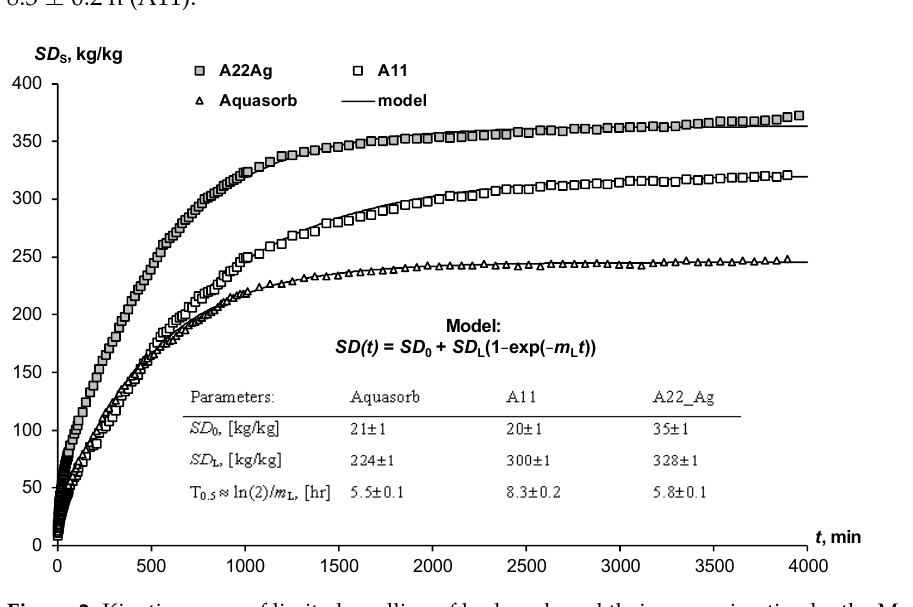
Figure 2. Kinetic curves of limited swelling of hydrogels and their approximation by the Model (27). where SD 0 and SD L are the initial and final (limiting) degree of swelling of the hydrogel, m L , [h − 1 ] is the kinetic constant, approximately (if SD 0 << SD L ) related to the half-life of the swelling process: T 0.5 ln(2)/ m L . The analysis of the parameters presented in Figure 2 shows that the half-life of the swelling process varied from 5.5 ± 0.1 1 h (Aquasorb) to 8.3 ± 0.2 h (A11).